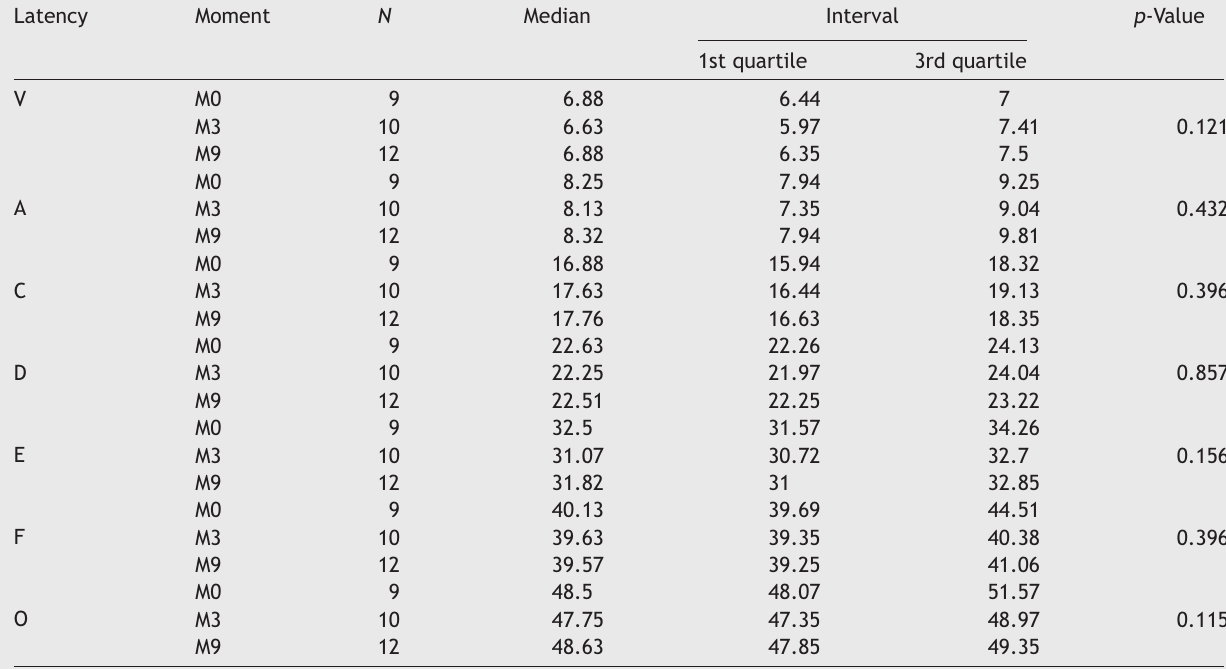
Comparison of ABR latencies with speech stimulus in the control